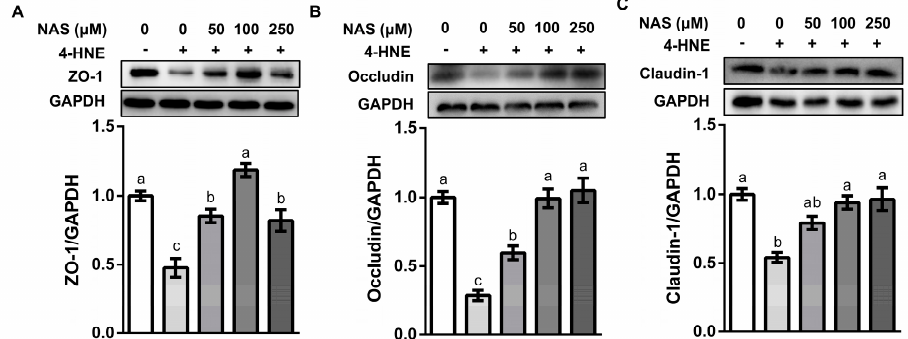
Figure 3. NAS enhanced the abundance of tight junction proteins. IPEC-1 cells were treated as described in Figure 2. Protein abundance for ZO-1 ( A ), occludin ( B ), and claudin-1 ( C ) were determined by Western blot analysis. Representative results from three independent experiments were provided, and values are means ± SEMs, n = 3. Means without a common letter differ, P < 0.05.